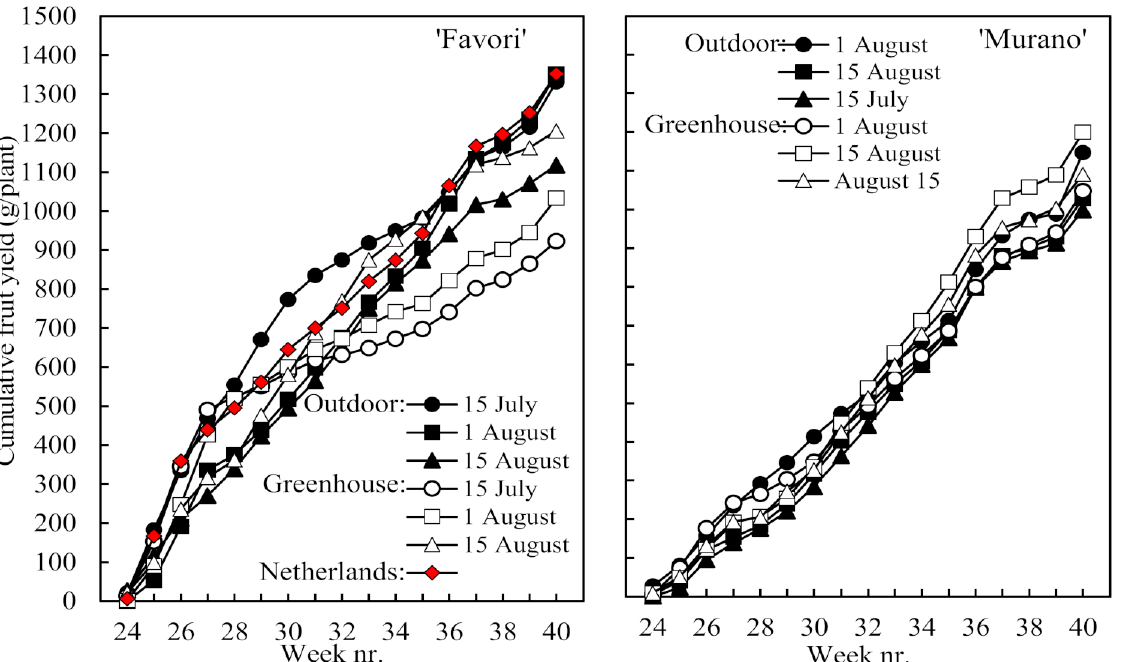
Figure 3. Time courses of cumulative berry yield in two everbearing strawberry cultivars as affected by rooting date and raising environment as indicated and subsequent cropping in a plastic tunnel in the following year. Results for imported ‘Favori’ plants included for comparison. The data are means of three replicates with nine plants of each